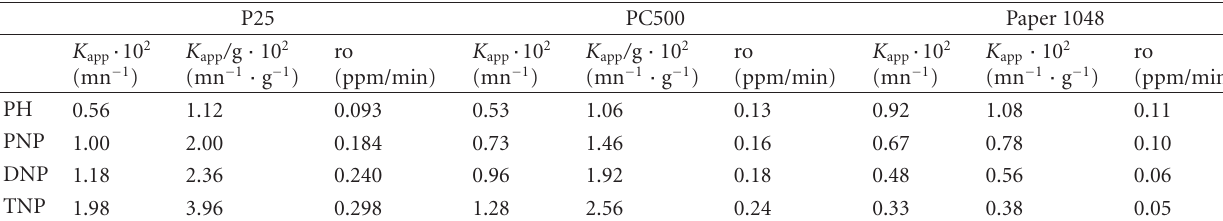
Table 3: Kinetic data of the photocatalytic degradation of nitrophenols.